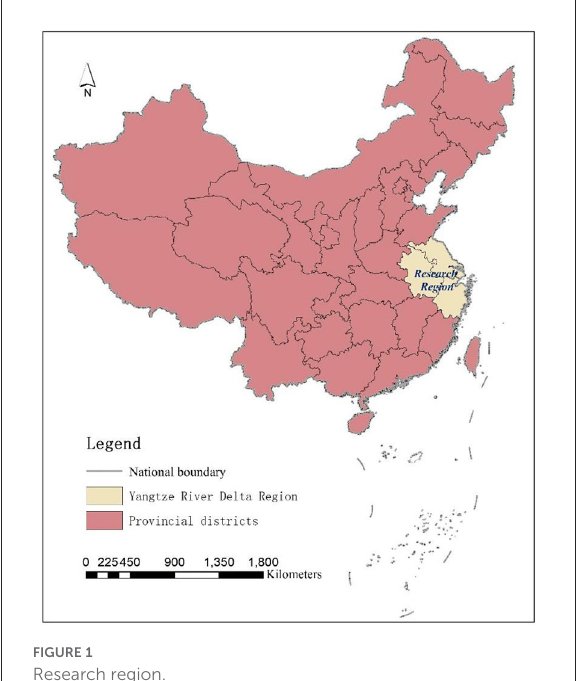
FIGURE1 Research